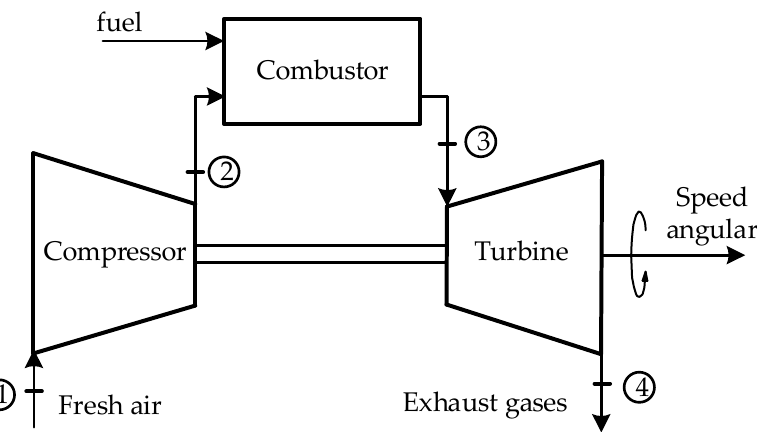
Figure 1. Typical schematic of an open-loop GT system.